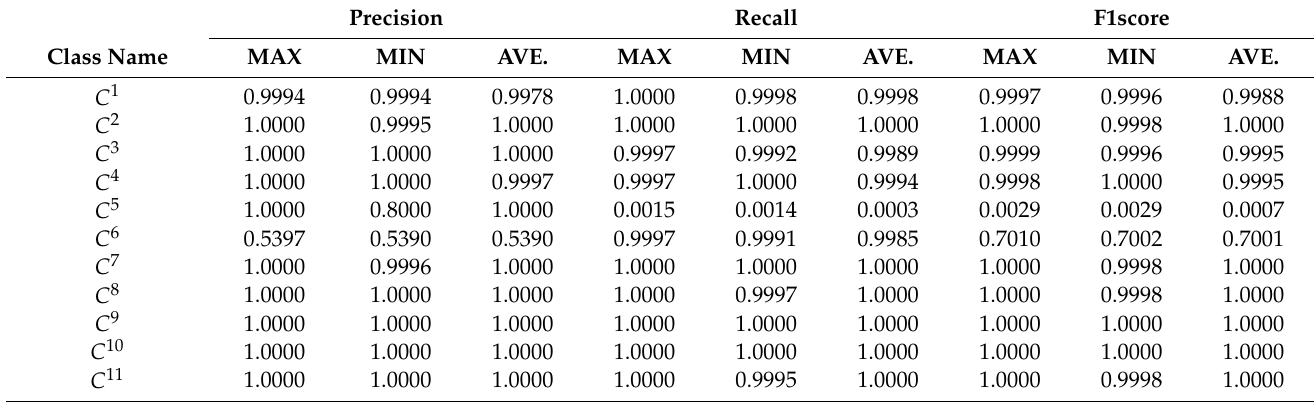
Table 10. Performance analysis for N-BaIoT with RF and MI feature selection on the test dataset. Precision